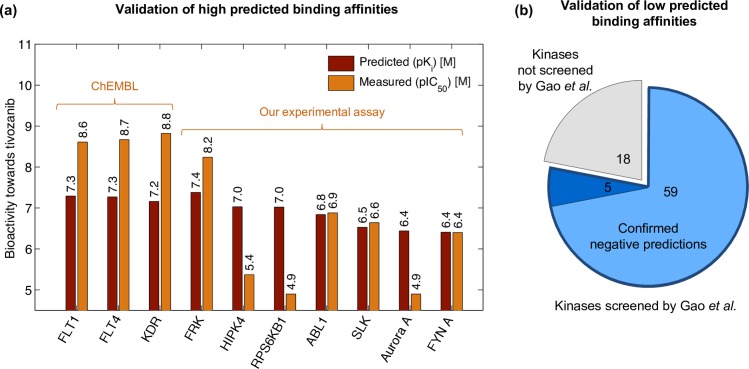
Prediction of target interactions for an investigational kinase inhibitor tivozanib.(a) Predicted and measured bioactivity profiles of tivozanib against its 3 established on-targets (FLT1, FLT4, KDR; average bioactivity from ChEMBL; S3 Table) and 7 predicted off-target kinases tested in our experimental assay. Pearson correlation r = 0.668 (p = 0.035). When no clear compound-kinase interaction was observed in our assay, the pIC50 value was set to 4.9 M, corresponding to the highest drug concentration used (12,500 nM). Predicted values belong to approximately constant range because we focused on experimental validation of the model-predicted off-target interactions. Three of them turned out to be false positives, and therefore the range of experimental results varies more than the range of predicted values. (b) Evaluation of negative interaction predictions from the model. Among 82 kinases with low predicted binding affinities (pKi < 6 M), 64 were screened by Gao et al., and 59 of these are not likely targets of tivozanib (as they have at least 50% of the activity remaining at the high compound concentration of 1 μM).